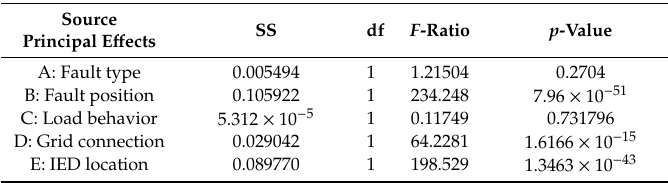
Table 11. ANOVA for each factor .